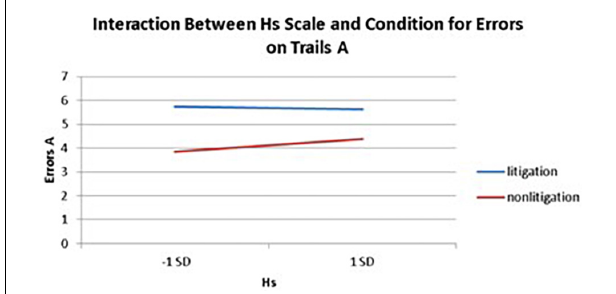
FIGURE 5 | Predicting the interaction between the Hs scale and condition when predicting errors on Trails A of the TMT.